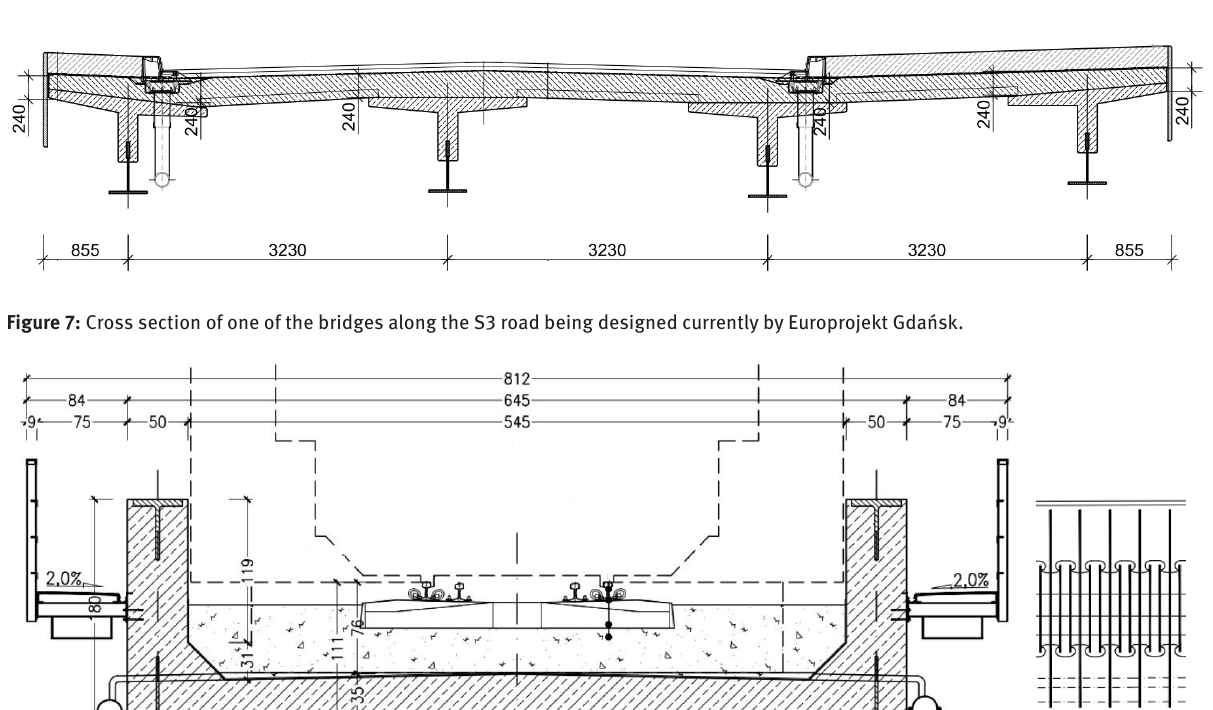
Figure 6: Hybrid girder of Sobieszewo bridge [7].